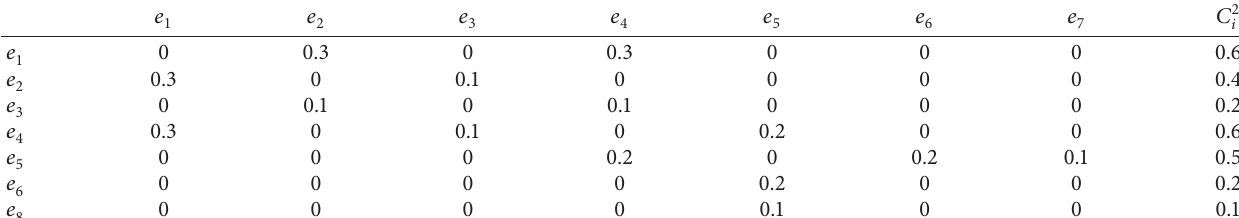
) with choice values C 2 2